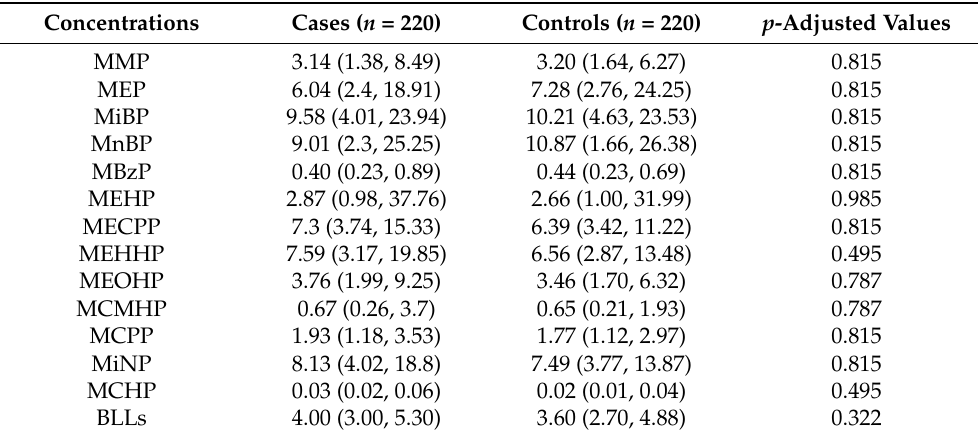
Table 2. Urinary concentrations of phthalate metabolites ( µ g/g) and blood lead levels ( µ g/dL) in study population.